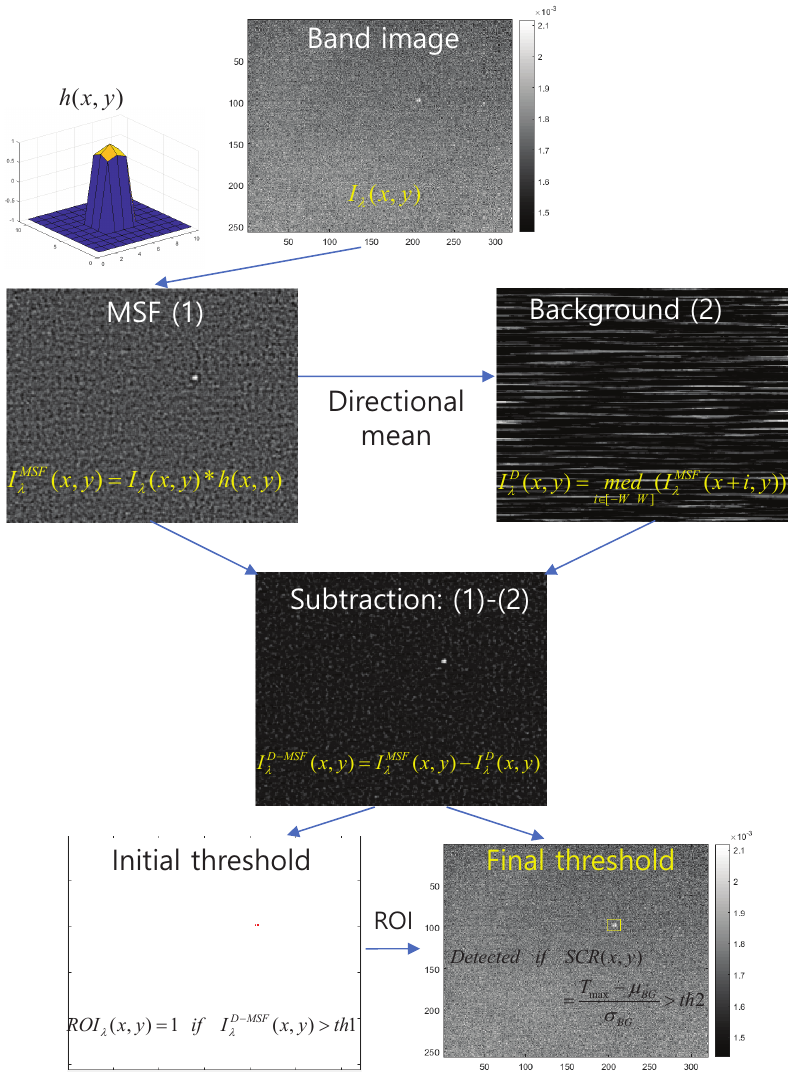
Figure 6. Operational flow of the directional-mean subtraction filter (D-MSF) for small-target detection in a band